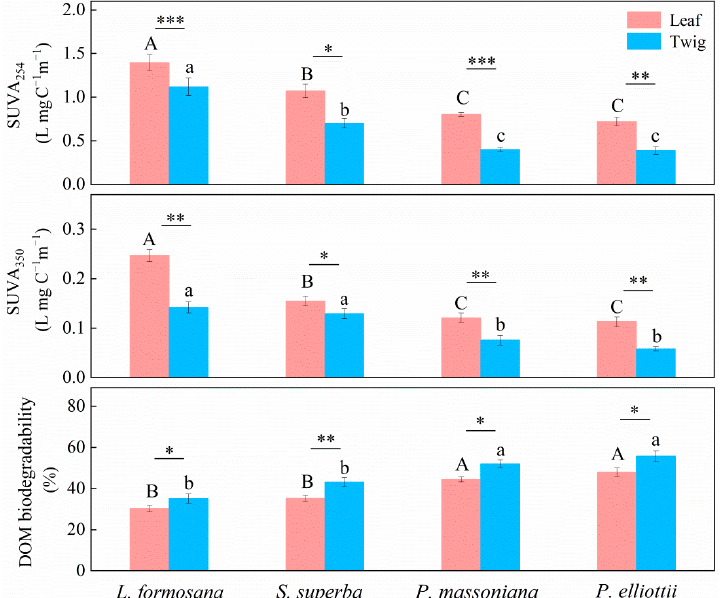
Figure 1. Optical properties and biodegradability of tree litter-derived dissolved organic matter (DOM) in subtropical plantations in southern China. The error bars are the standard error of the means ( n = 6). Different uppercase letters indicate the significant differences among the tree leaf treatments ( p < 0.05), and different lowercase letters indicate the significant differences among the tree twig treatments ( p < 0.05). For each tree species, *, **, and *** indicate the significant differences between leaf and twig at the levels of p < 0.05, p < 0.01, and p < 0.001, respectively.